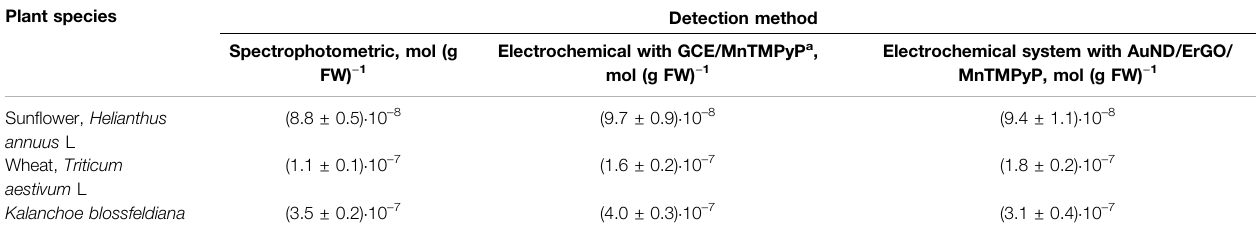
TABLE 1 | Analysis of the content of hydrogen peroxide in leaves of various plant species using spectrophotometric and electrochemical quanti fi cation ( p (cid:2) 0.95, n (cid:2) 5).